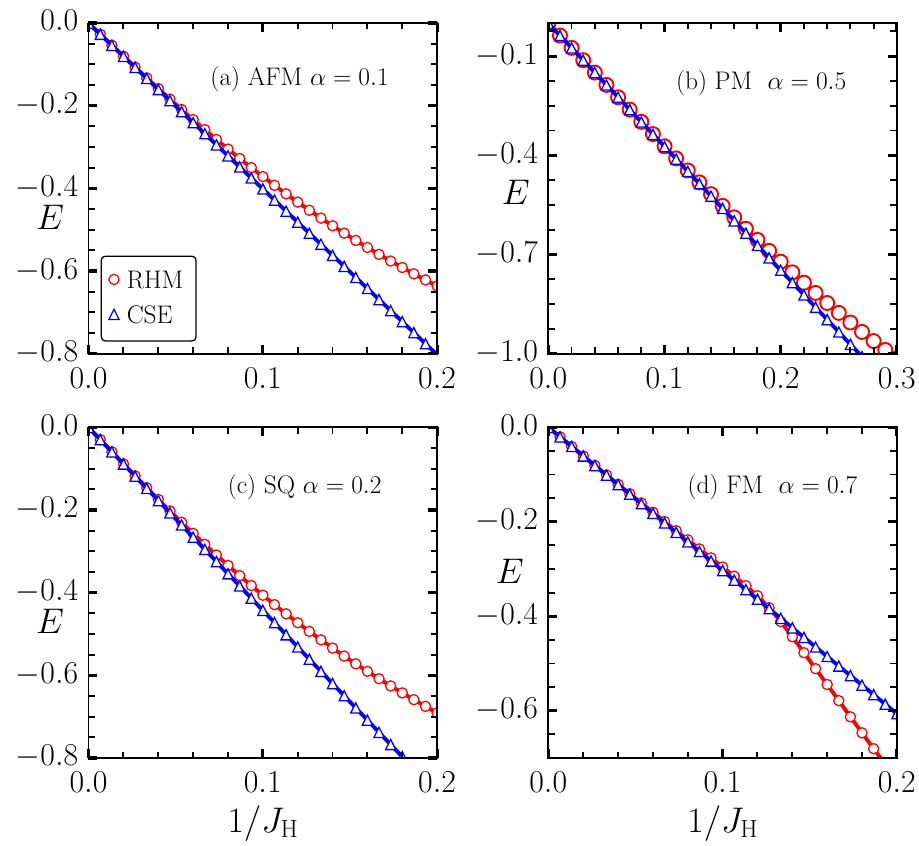
Figure 1. 1 / J H dependence of energy per site calculated via exact diagonalization of the Rashba Hund’s Hamilonian (red circles) and that calculated from the low-energy spin Hamilonian (blue triangles) for different magnetic states and for different α : ( a ) 120° state, ( b ) random configuration representative of a paramagnetic state, ( c ) single-Q spiral state, and ( d ) ferromagnetic state. All energies are measured in units of the bare 1 hopping parameter t 0 =